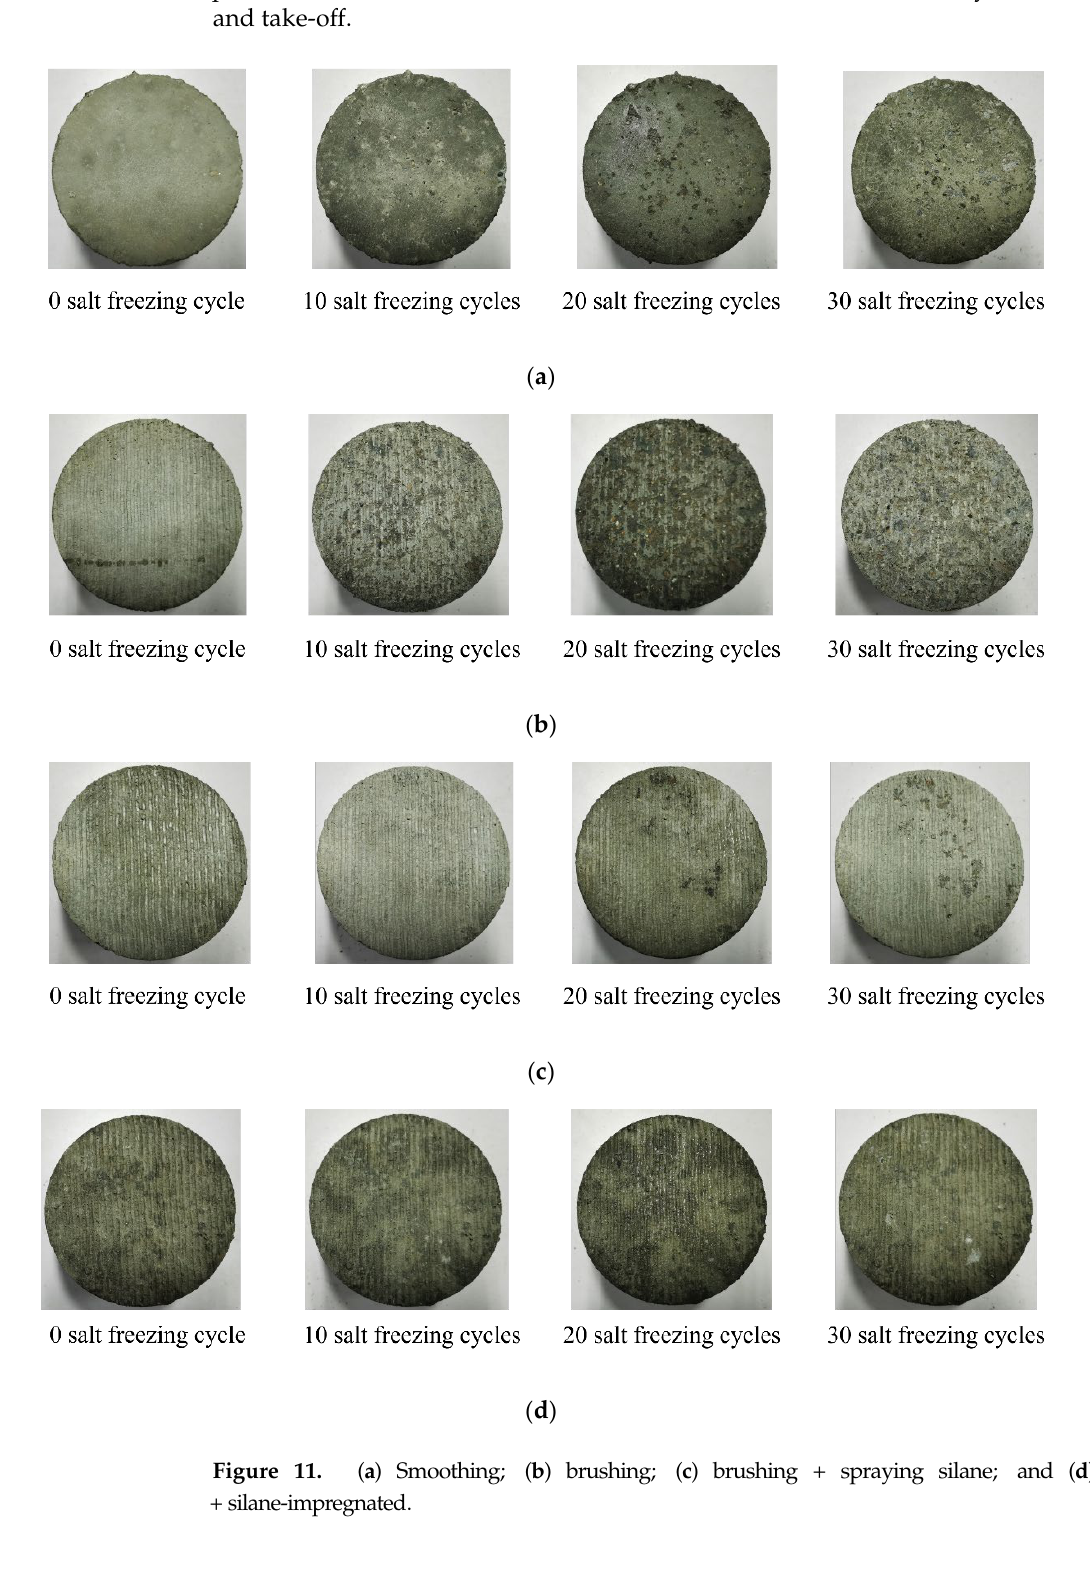
Figure 11. ( a ) Smoothing; ( b ) brushing; ( c ) brushing + spraying silane; and ( d ) brushing + silane-impregnated.